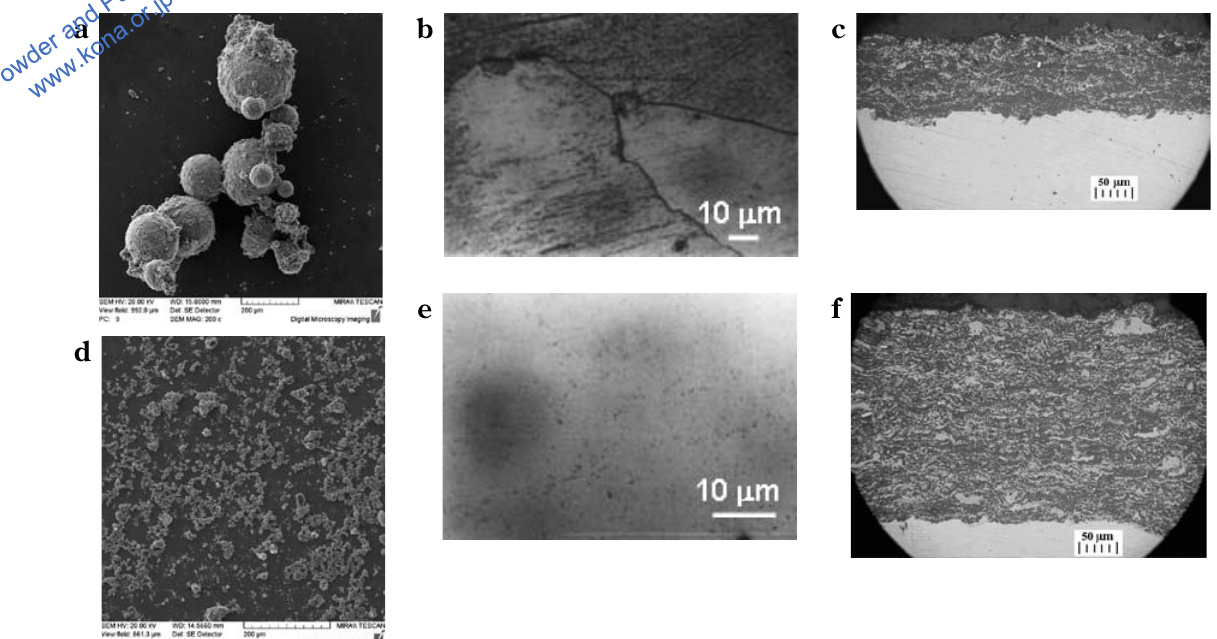
Fig.1 Morphology (a, d) and cross-sections of NiAl powders (b, e); cross-sections of detonation spray coating from them (c,